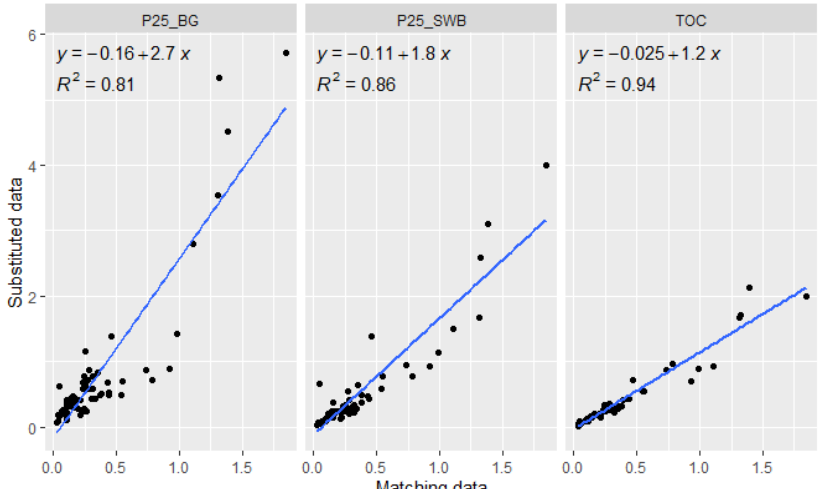
Figure 4. The comparison of the BIO-MET calculated RCR for Cu between the matching data and substituted data (P25_BG—the 25th percentile of the available DOC data and/or the DOC data calculated by the TOC from the Bulgarian monitoring network results during 2020; P25_SWB—the 25th percentile of the DOC data calculated by the TOC for the respective water body; TOC—the matching DOC data calculated by TOC).